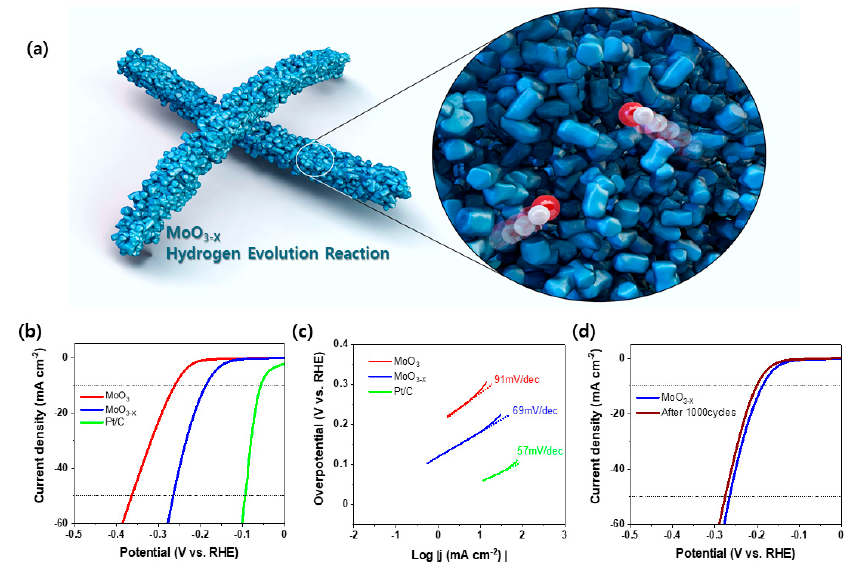
Figure 4. ( a ) Schematic illustration of the MoO 3-X electrode during hydrogen evolution reactions. ( b ) Polarization curves of the MoO 3 , MoO 3-X , and Pt/C electrodes. ( c ) Tafel plots of the MoO 3 , MoO 3-X , and Pt/C electrodes. ( d ) Stability test of the MoO 3-X electrode.